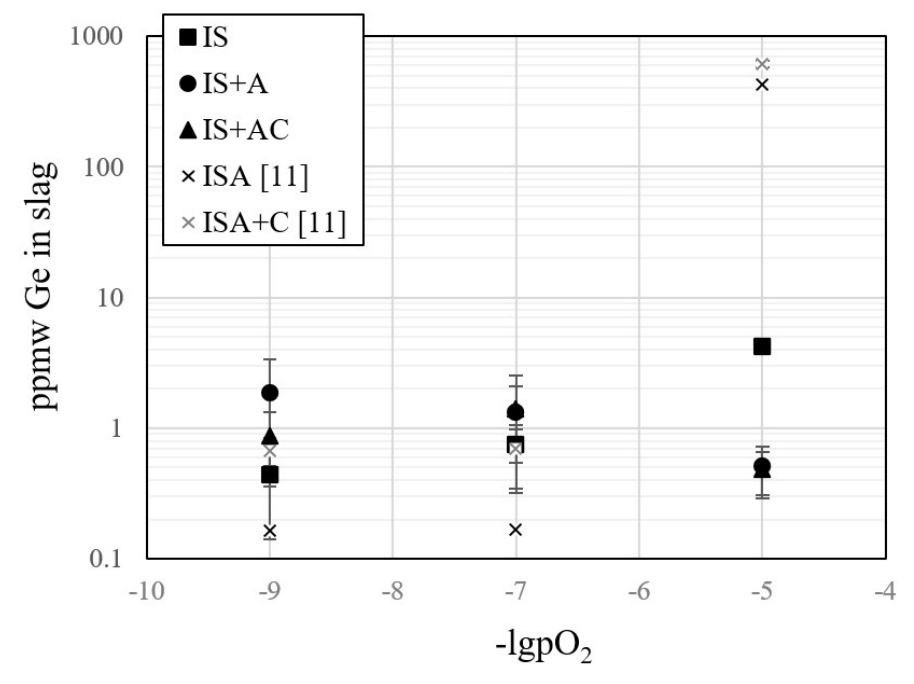
Figure 5. The concentration of germanium in di ff erent iron–silicate based slags as a function of oxygen partial pressure at 1300 ◦ C. ISA and ISA + C indicate to iron–silicate slags, including ~15–20 wt% alumina (ISA) and ~15–20 wt% alumina and 5 wt% lime (ISA + C)